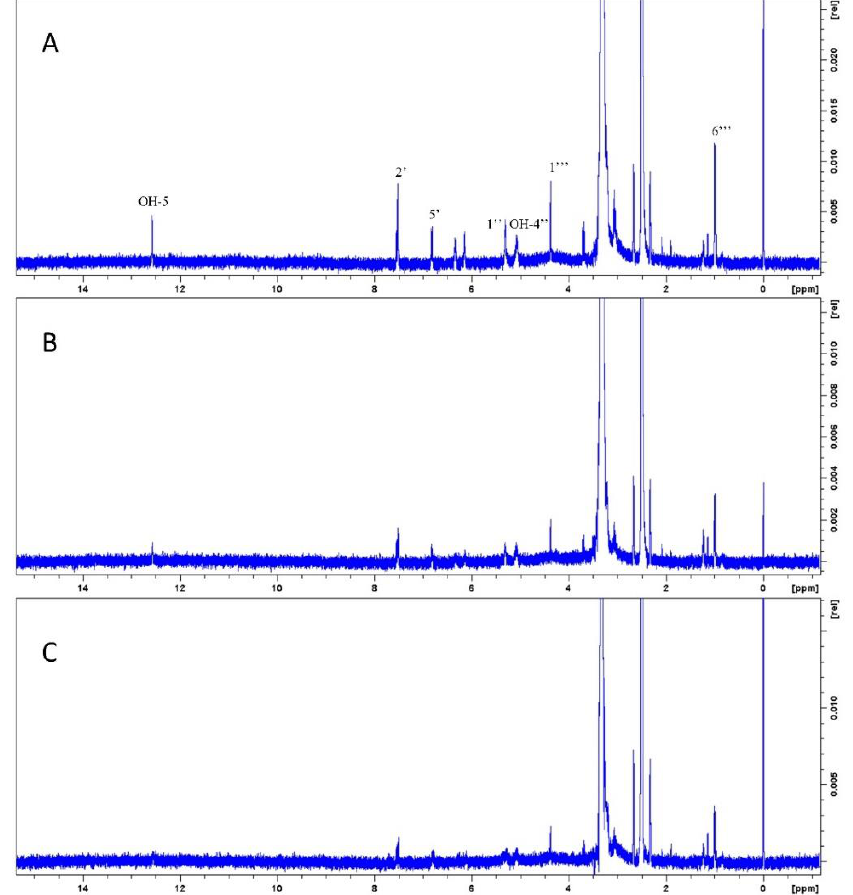
Figure 6. Experimental determination of the limit of detection (LOD) through a 1 H-NMR spectrum (400 MHz, DMSO-d 6 ). Rutin concentration: ( A ) 0.250 mM, ( B ) 0.125 mM, and ( C ) 0.100 mM. As concentration decreases, the distinctive molecular profile vanishes; then, the LOD is the lowest concentration at which the relevant signals in the spectrum can be visually distinguished. The rutin signals are clearly seen at 0.125 mM.